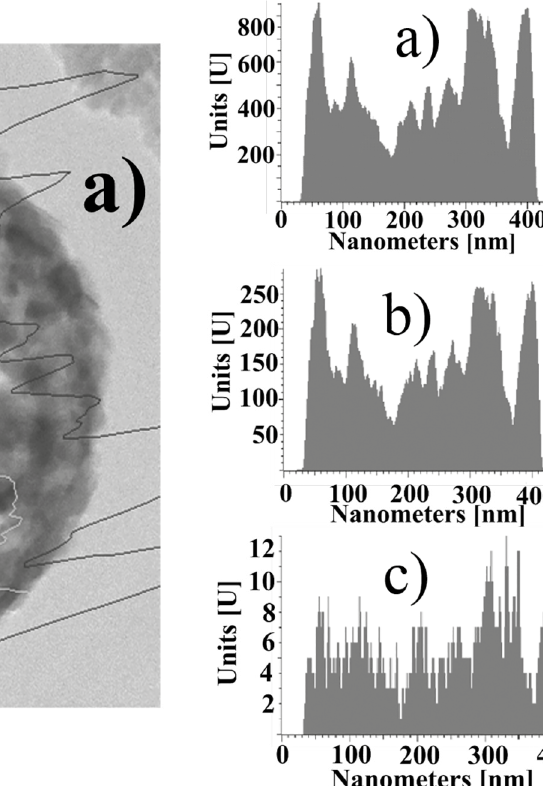
the equilibrum was attached after 15 minutes of contact time. These results were similar to those previously reported by Naushad et al. 2,36 who found that the rate of adsorption was higher in the early stages of the removal process and